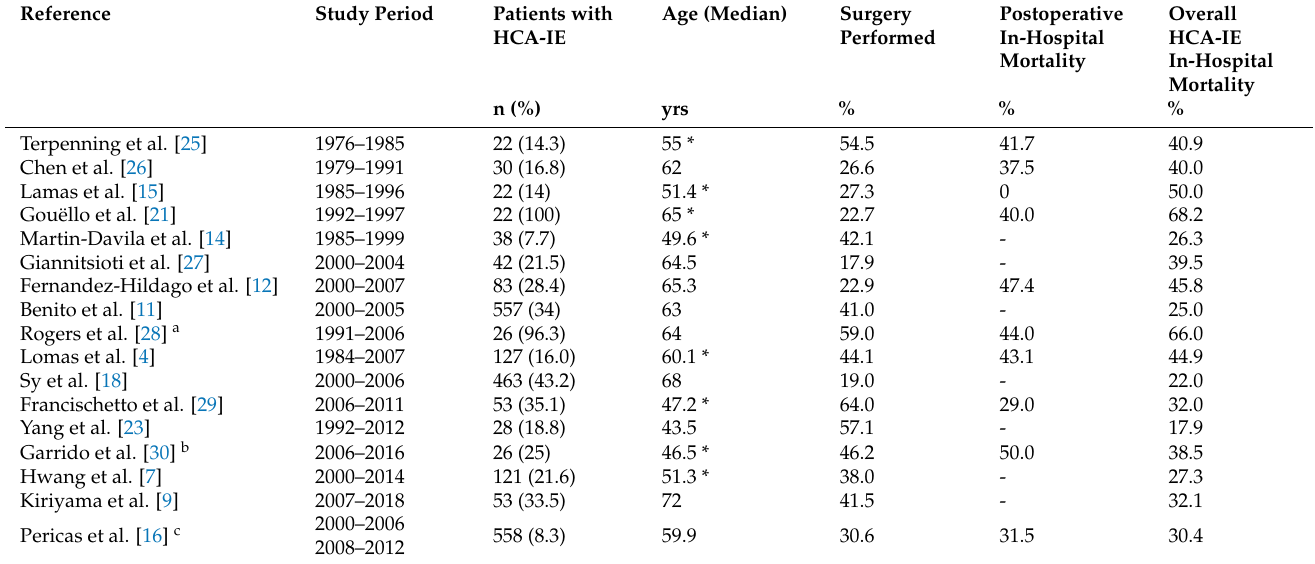
Table 2. Surgical treatment in healthcare-associated infective endocarditis